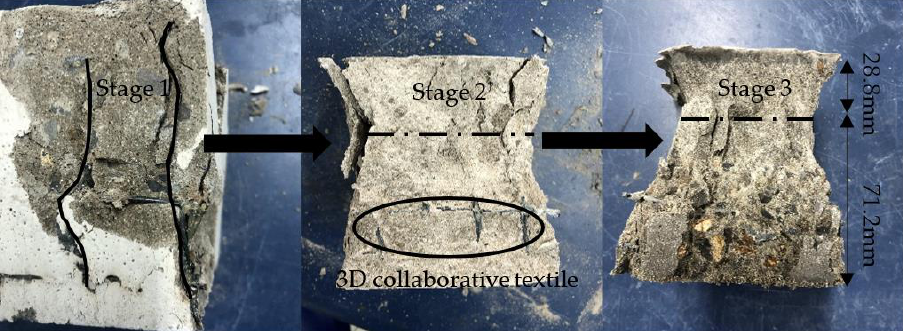
Figure 5. Failure mode of 3D-TRSSC ultimate strength.